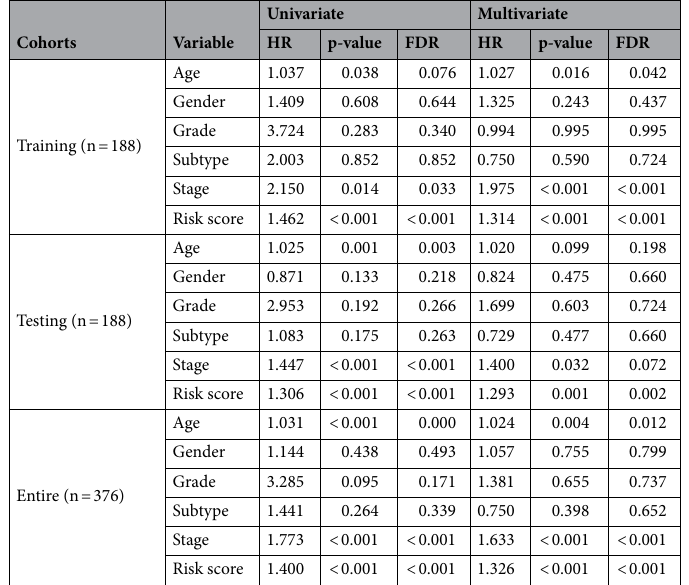
Table 3. Independence analysis results of the five PIRMGs signature in three cohorts. HR hazard ratio, Subtype muscle-invasive BCa and non-muscle-invasive BCa, FDR p-values adjusted in FDR method.